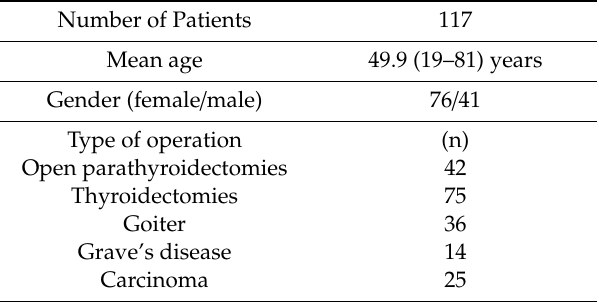
Table 1. Descriptive